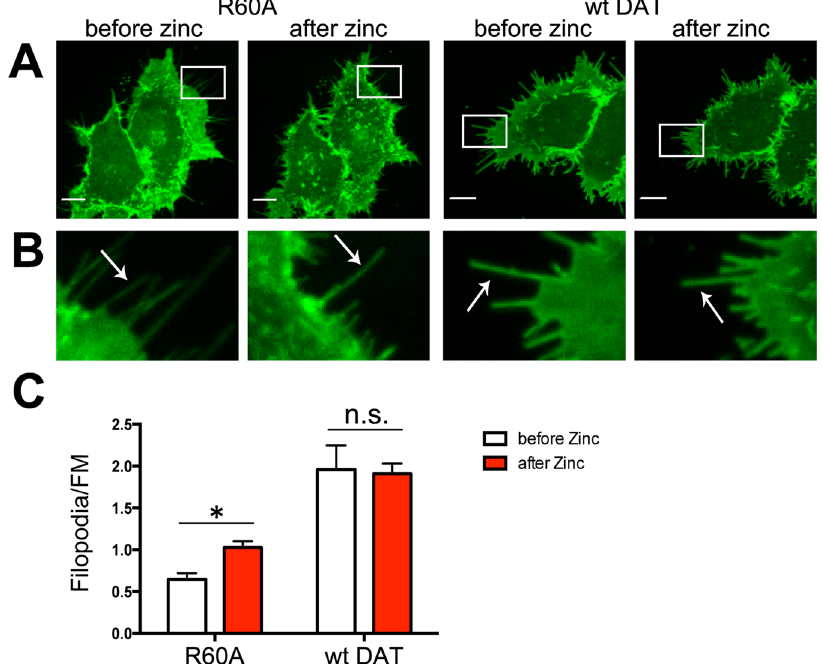
Figure 7. Binding of zinc increases the concentration of R60A in filopodia of HEK293 cells. ( A) Cells transiently expressing YFP-DAT or the R60A mutant of YFP-DAT were incubated with 10 μ M zinc chloride for 30 min at RT. Live-cell imaging was performed through the 515 nm (YFP, green ) filter channel. Maximal z-projections of 5 consecutive x-y-confocal planes are shown. Scale bars, 10 μ m. ( B ) Insets represent high magnification images of the regions marked by the white rectangle in ( A ). Arrows point to examples of peripheral filopodia. ( C ) The filopodia/FM ratios of YFP fluorescence intensities were quantitated in experiments exemplified in ( A , B ). Results are shown as mean ± SEM, n = 10. * p <